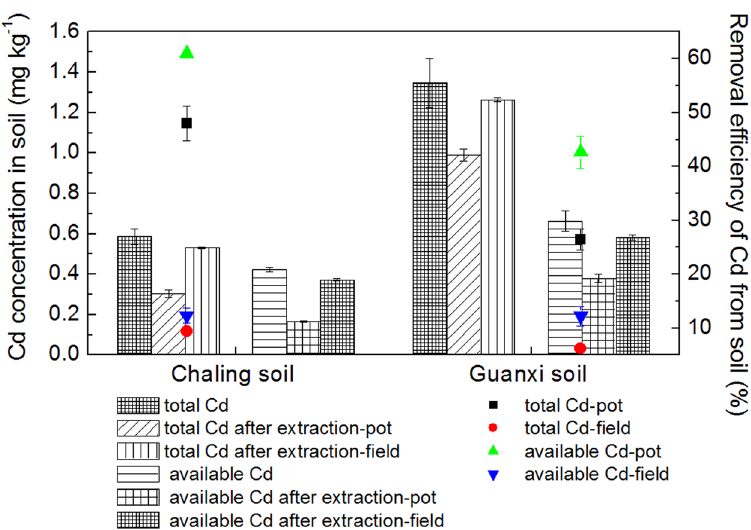
Figure 2. Cd concentrations in soils before and after phytoextraction and Cd removal efficiency by tobacco. Cd concentration in soil (mg kg − 1 ) expressed as bar plots with SE of means, while Cd removal efficiency (%) expressed as the symbols ■ , ● , ▲ and ▼ represent means with